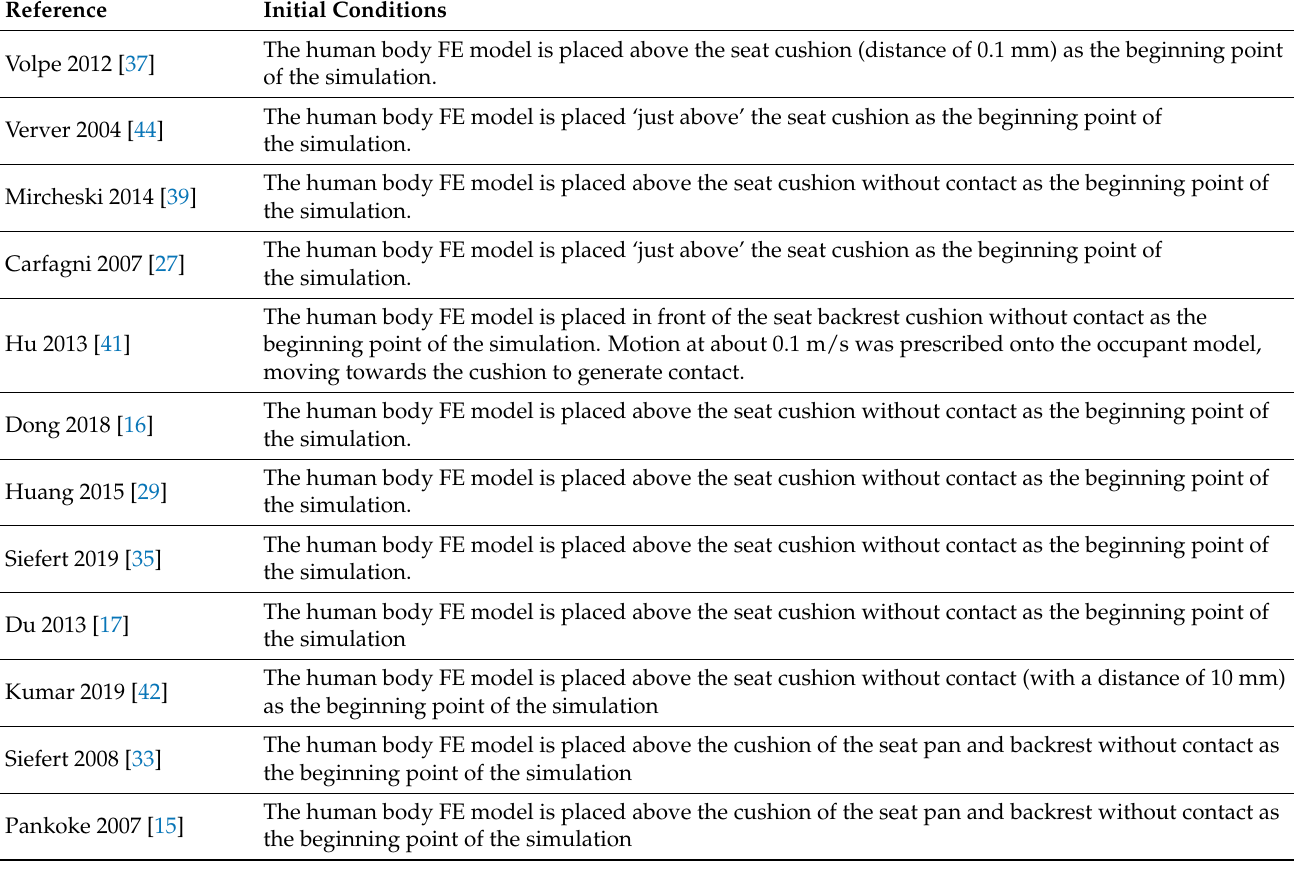
Table A2. Initial conditions applied for FEA in different